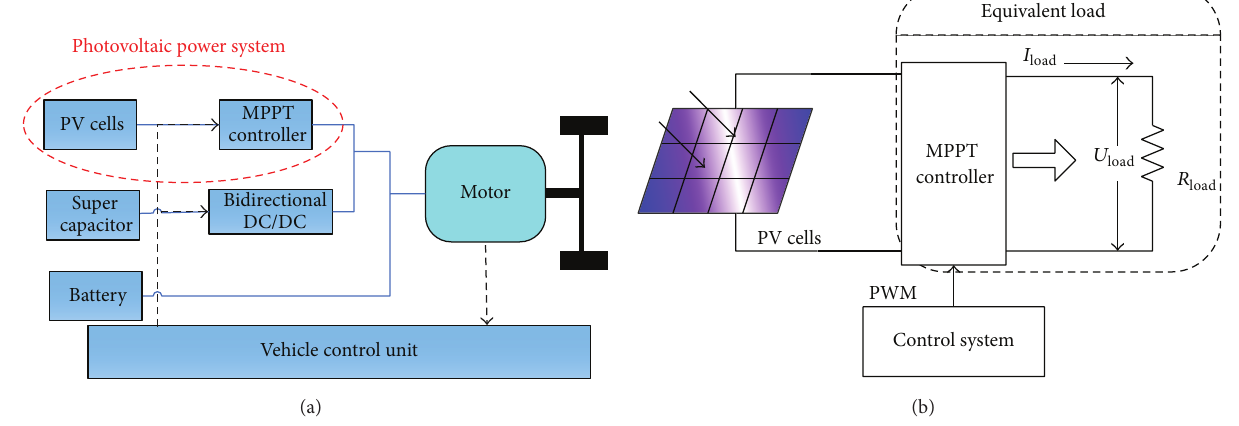
Figure 1: (a) The structure of hybrid power system. (b) The structure of photovoltaic power system.